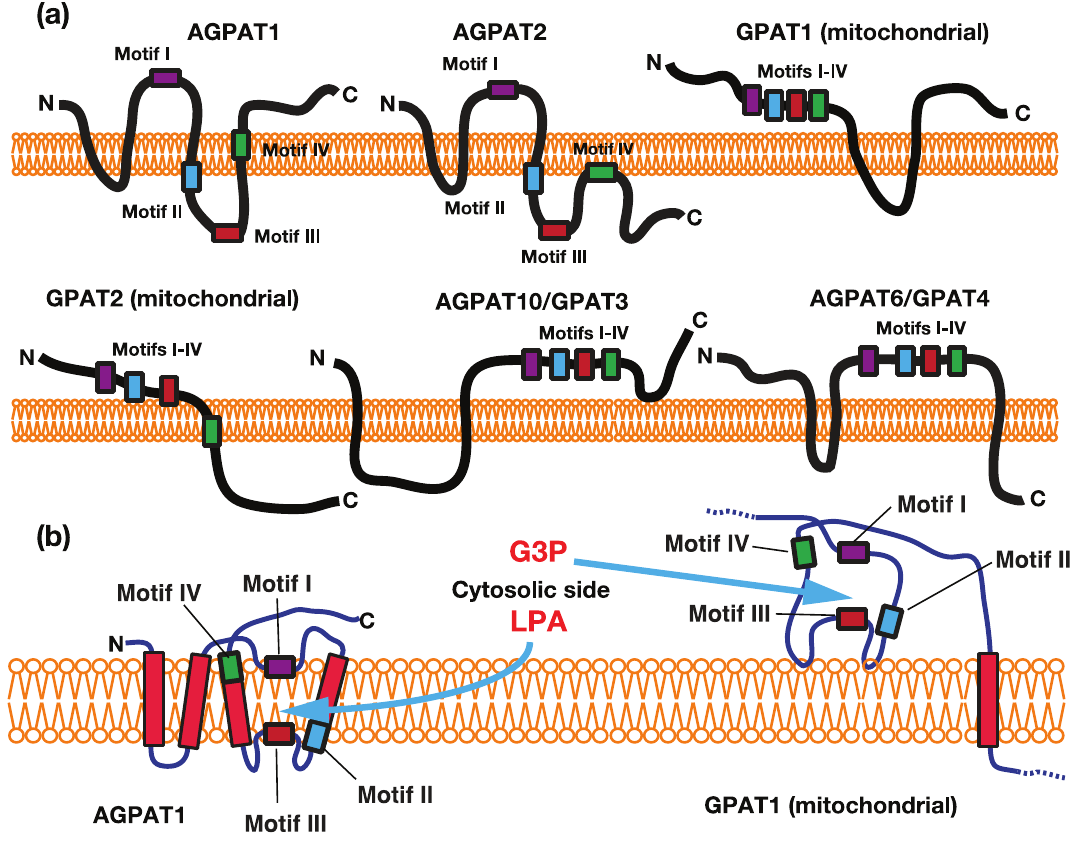
Figure 3. ( a ) Predicted transmembrane segments and relationship to the acyltransferase motifs of GPAT/AGPAT family enzymes. The transmembrane segments of each enzyme were predicted by several algorithms including TMHMM and SOSUI. The locations of acyltransferase motifs I-IV have also been depicted; ( b ) Proposed models of the catalytic sites of AGPAT1 and GPAT1. The top or bottom sides of the membrane show the cytosol or lumen (interspace) of the ER and mitochondrial outer